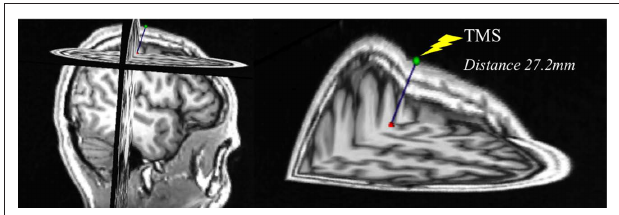
Figure 3 | exemplification of the Mri-based measurement of distance from scalp to hotspot in a 22-year-old